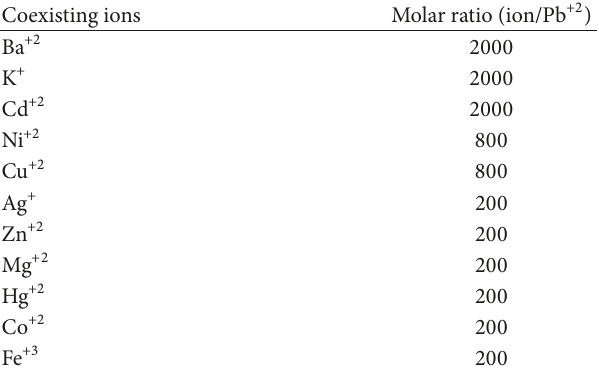
Table 2: Effect of the coexisting ions on the recoveries of the Pb